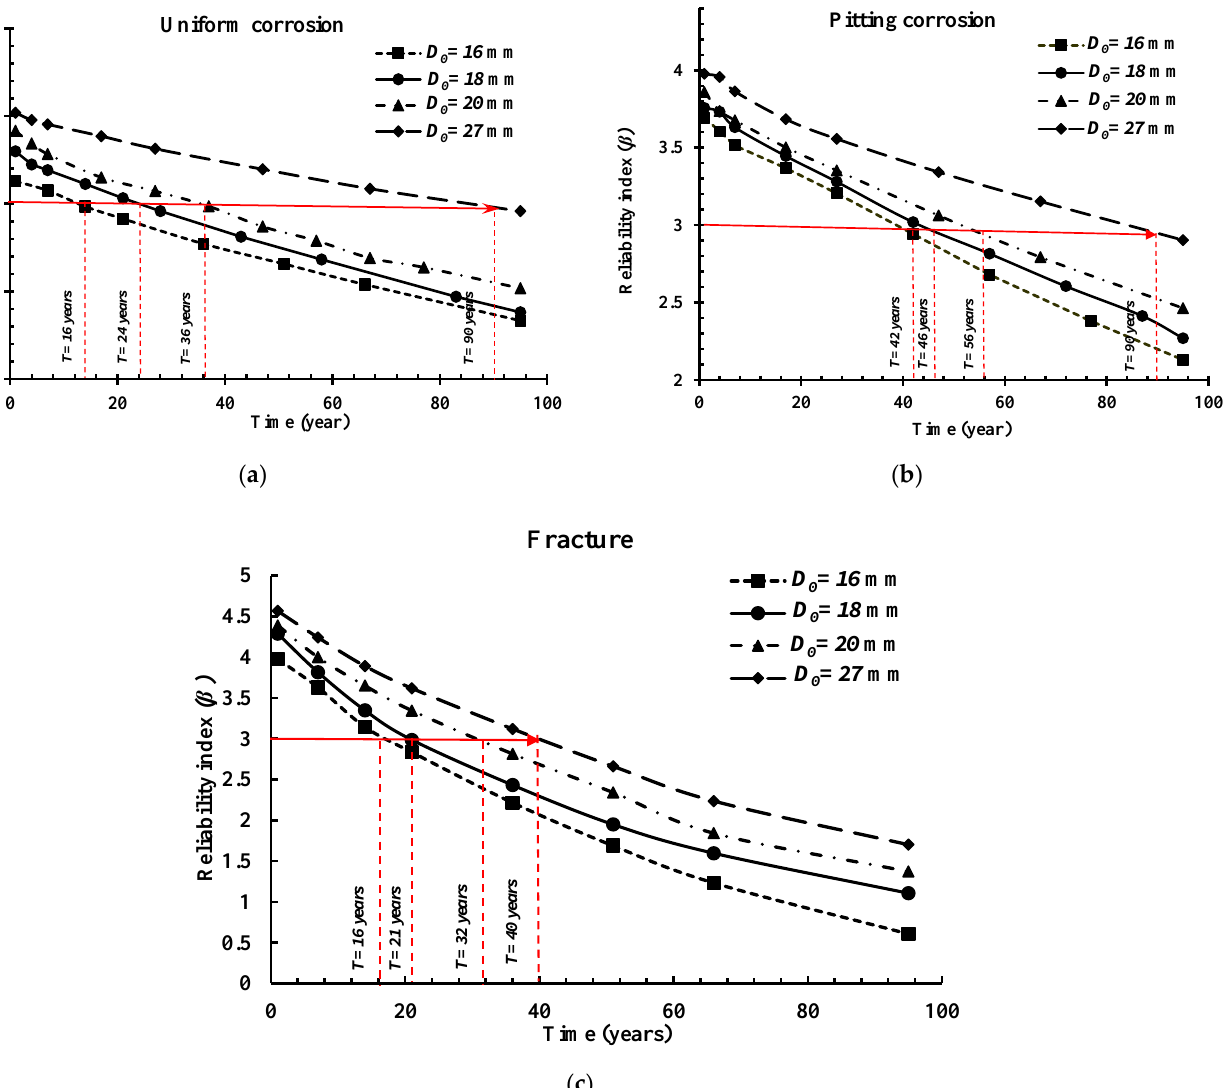
Figure 5. Influence of the nominal diameter of the bar ( D 0 ) on the reliability index results for the ( a ) uniform corrosion form, ( b ) pitting corrosion form, and ( c ) fracture failure mode.